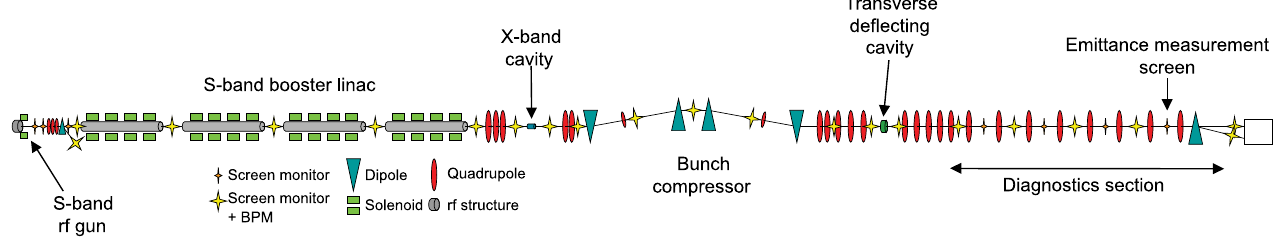
FIG. 1. Schematic layout of the SwissFEL Injector Test Facility (original configuration, not to scale). The total length of the beam line is approximately 60 m.